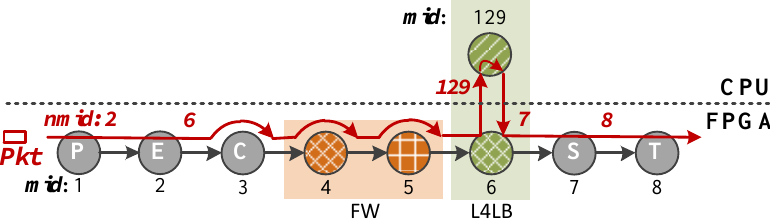
Figure 6. Performing L4LB by configuring nmid to direct outbound TCP packets passing through required modules.